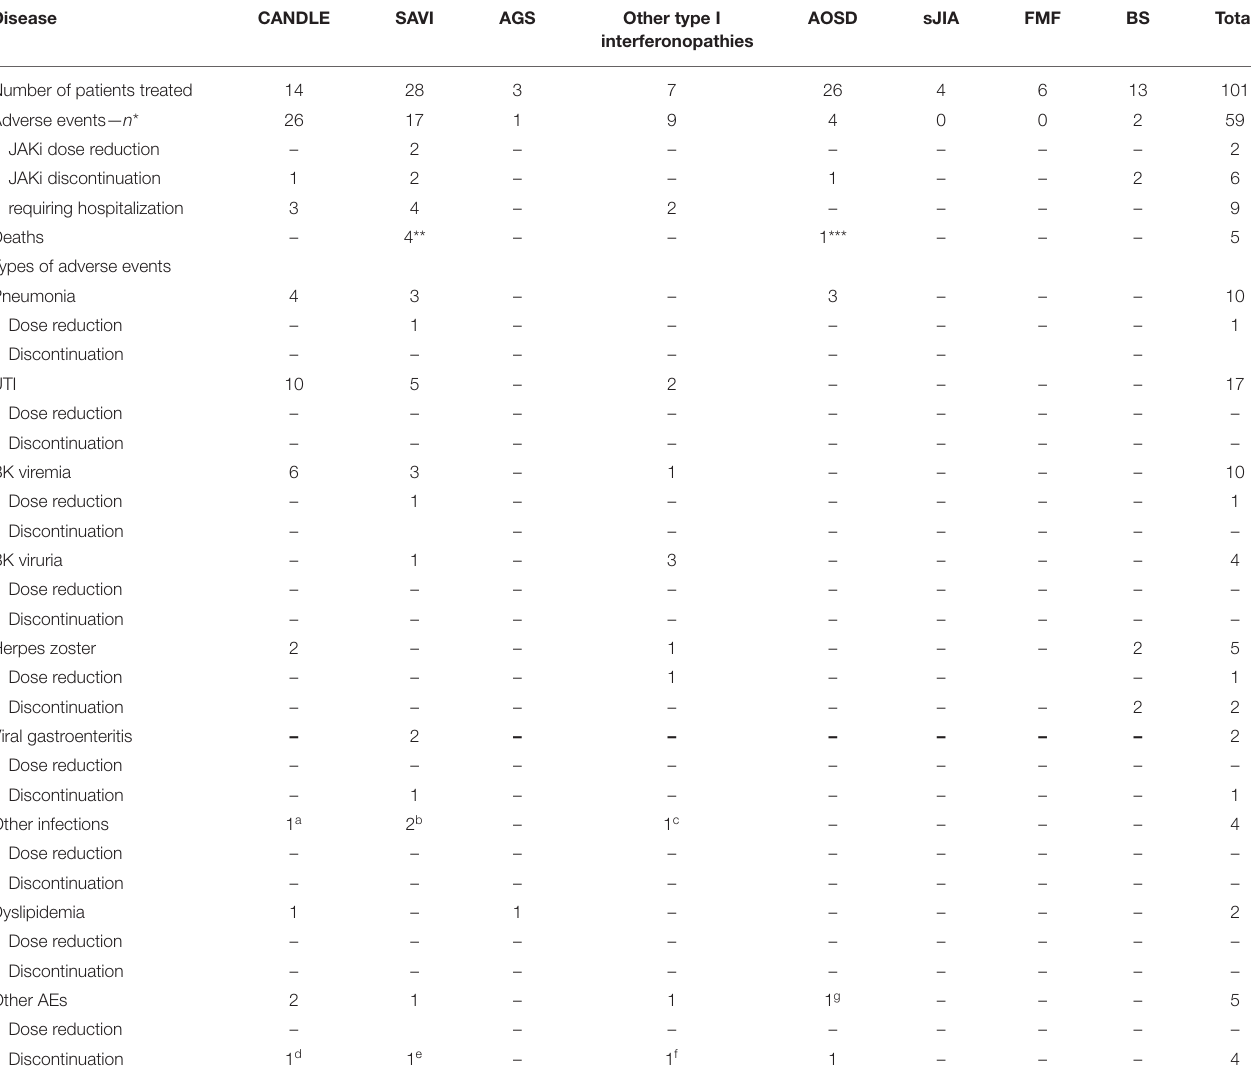
TABLE 2 | Overview of adverse events. Disease